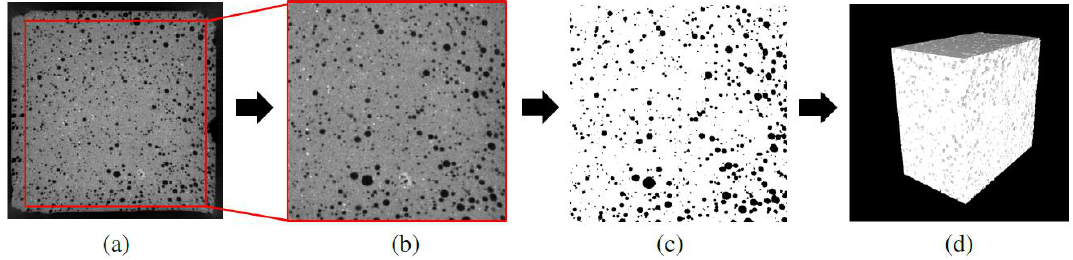
Figure 1. X-ray CT imaging process of the specimen with air-entraining admixture: ( a ) the original CT image, ( b ) region of interest (ROI), ( c ) binary image in 2D, ( d ) 3D binary image (Note: in the binary images, the white represents the solid phase, and the black regions are pores inside the specimen.).